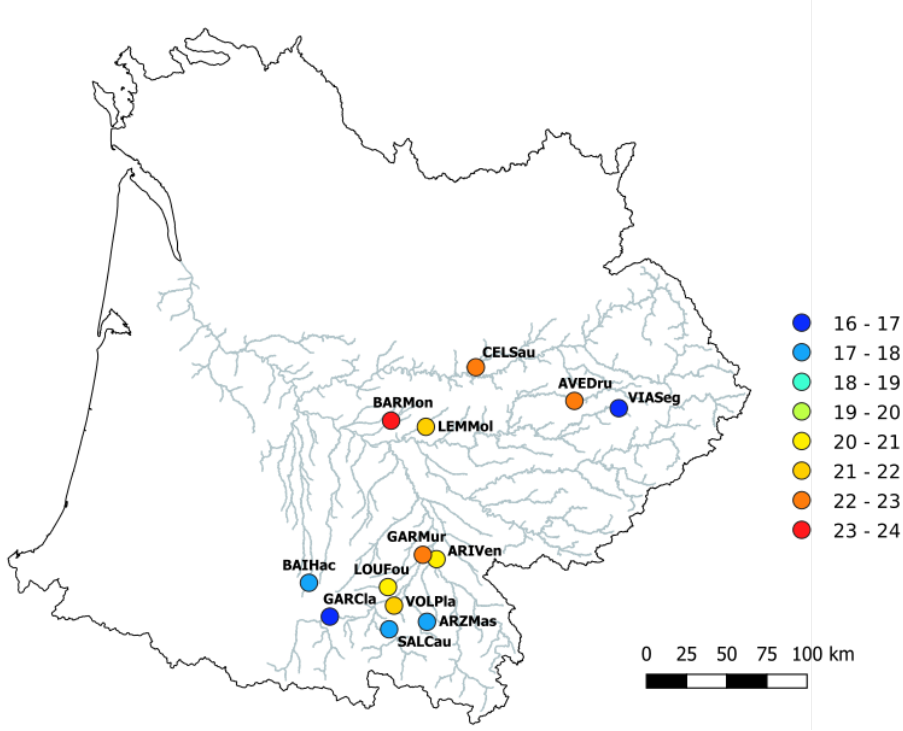
Figure 1. Distribution of the 13 sampling sites in the Garonne river basin. Names and localization are highlighted in bold. Twenty-four individuals per site and per species ( Gobio occitaniae and Phoxinus phoxinus ) have been sampled. Color of circles indicates mean water temperature ( ◦